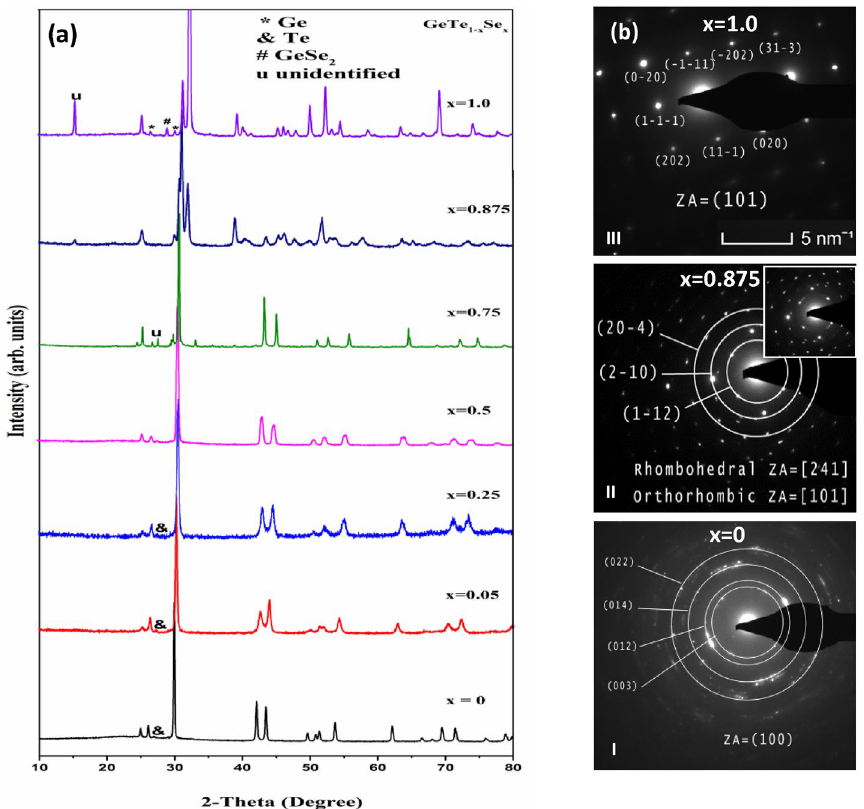
Figure 1. ( a ) XRD patterns of melt quenched GeTe 1−x Se x bulk samples 0 ≤ x ≤ 1.0. For x ≤ 0.75, the structure follows the rhombohedral and for x > 0.75, the structure changes to Orthorhombic. x = 0.875 sample shows mixed phases of both rhombohedral and orthorhombic structure. ( b ) Diffraction patterns of x = 0, 0.875 and 1.0, showing structural transition (I-III) complementary to XRD patterns. Inset in II is showing circular rings pattern with spot pattern indicating mixed